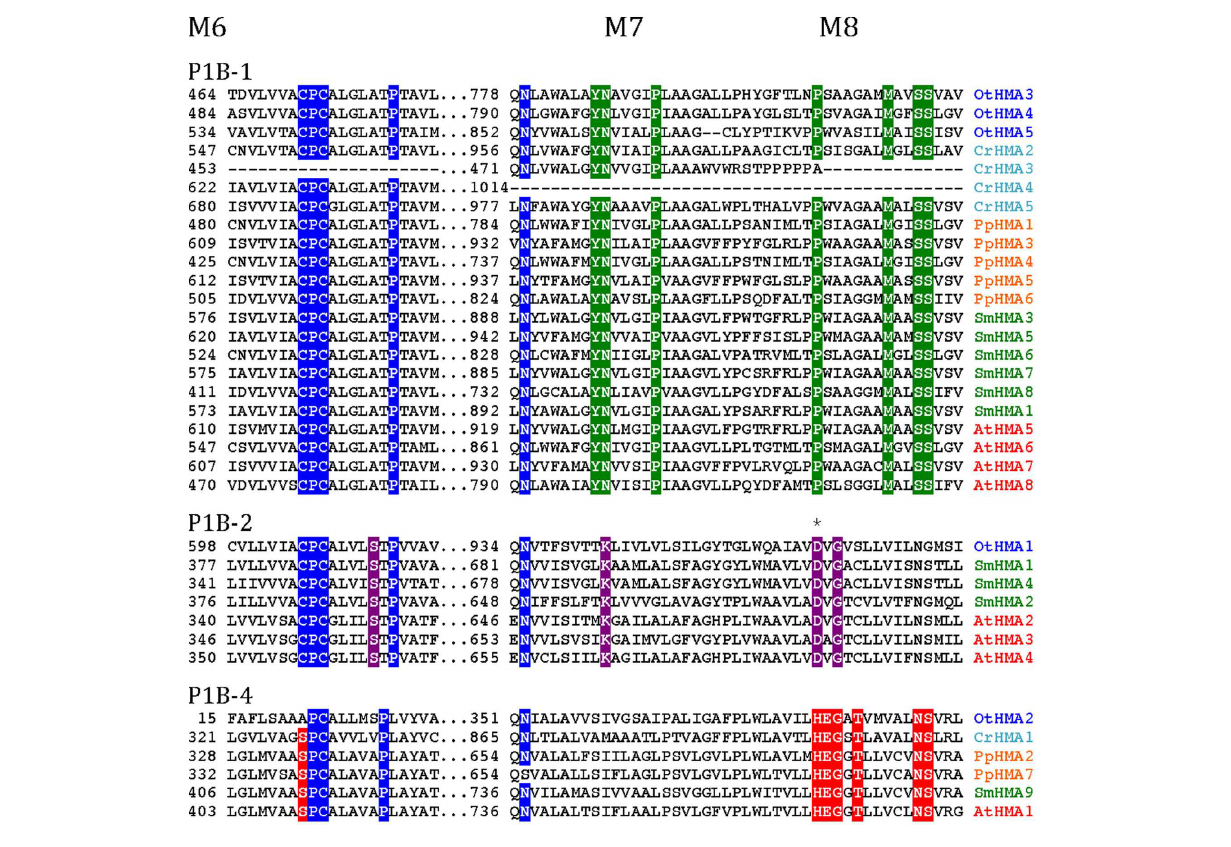
P2B ATPases: AUTOINHIBITED Ca 2 +